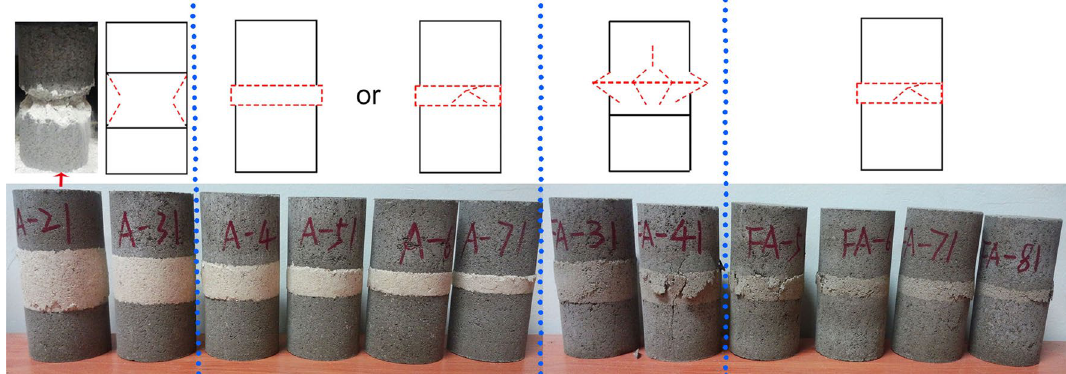
Figure 15. Uniaxial compression failure modes of ( a ) type I and ( b ) type II composite rock